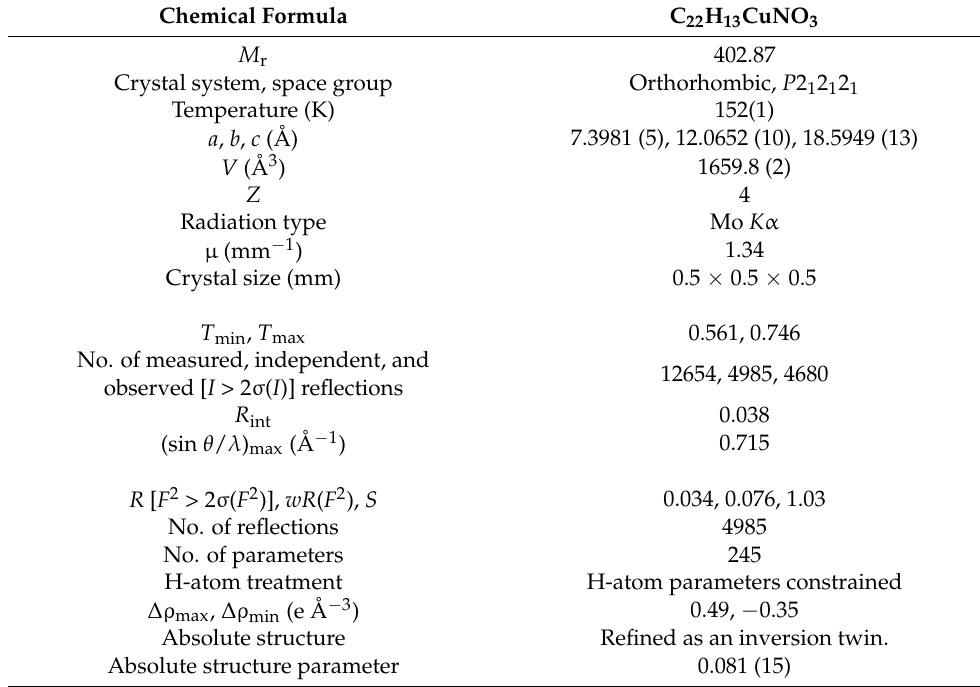
Table 1. Selected crystallographic data for 1